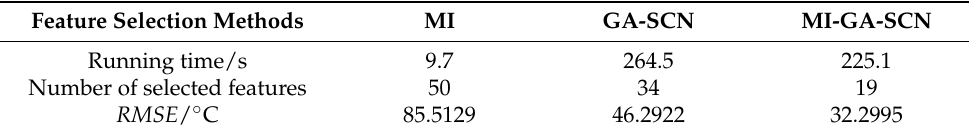
Table 2. Performance comparison of MI, GA-SCN and MI-GA-SCN.